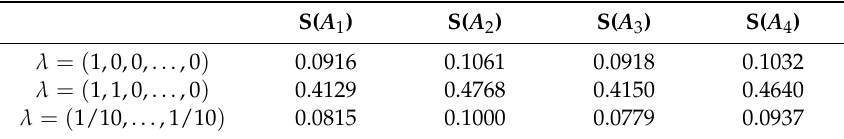
Table 2. The score functions values by taking di ff erent parameter vector λ